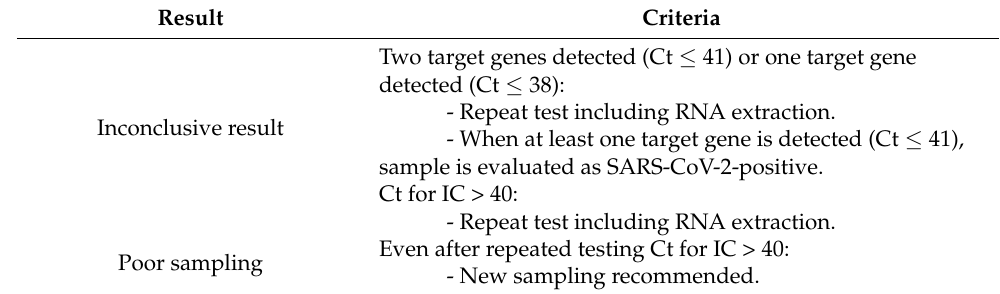
Table 1. Cont. Result